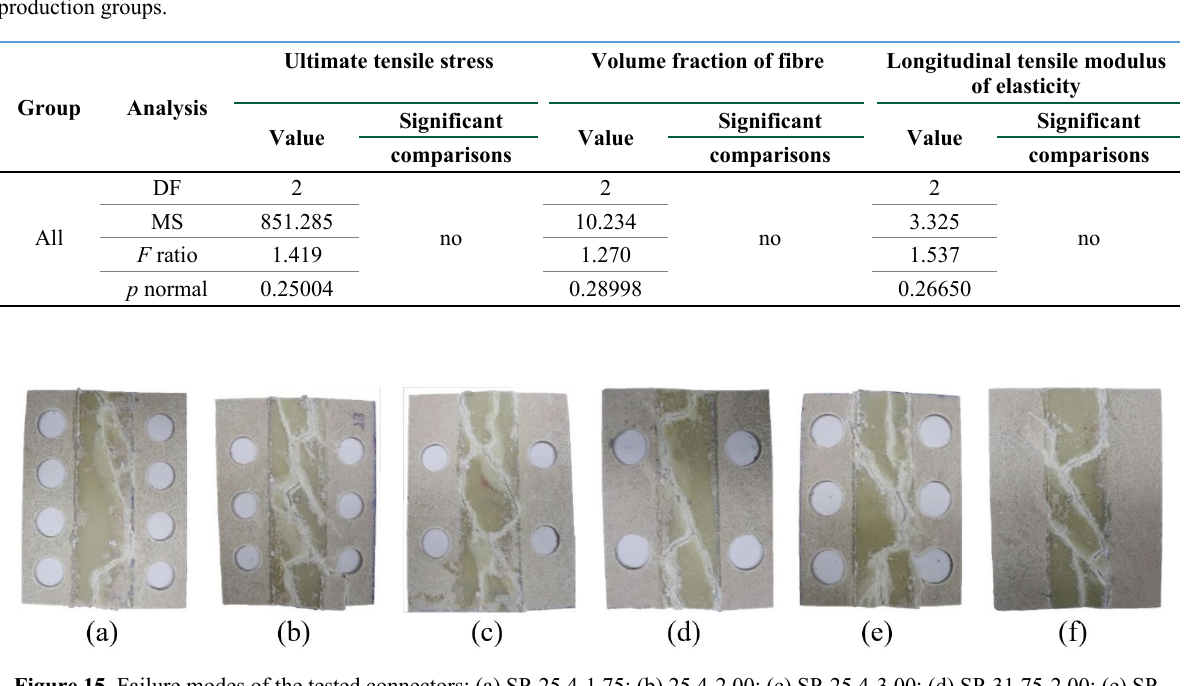
Figure 15. Failure modes of the tested connectors: (a) SP-25.4-1.75; (b) 25.4-2.00; (c) SP-25.4-3.00; (d) SP-31.75-2.00; (e) SP- 31.75-3.00; (f)